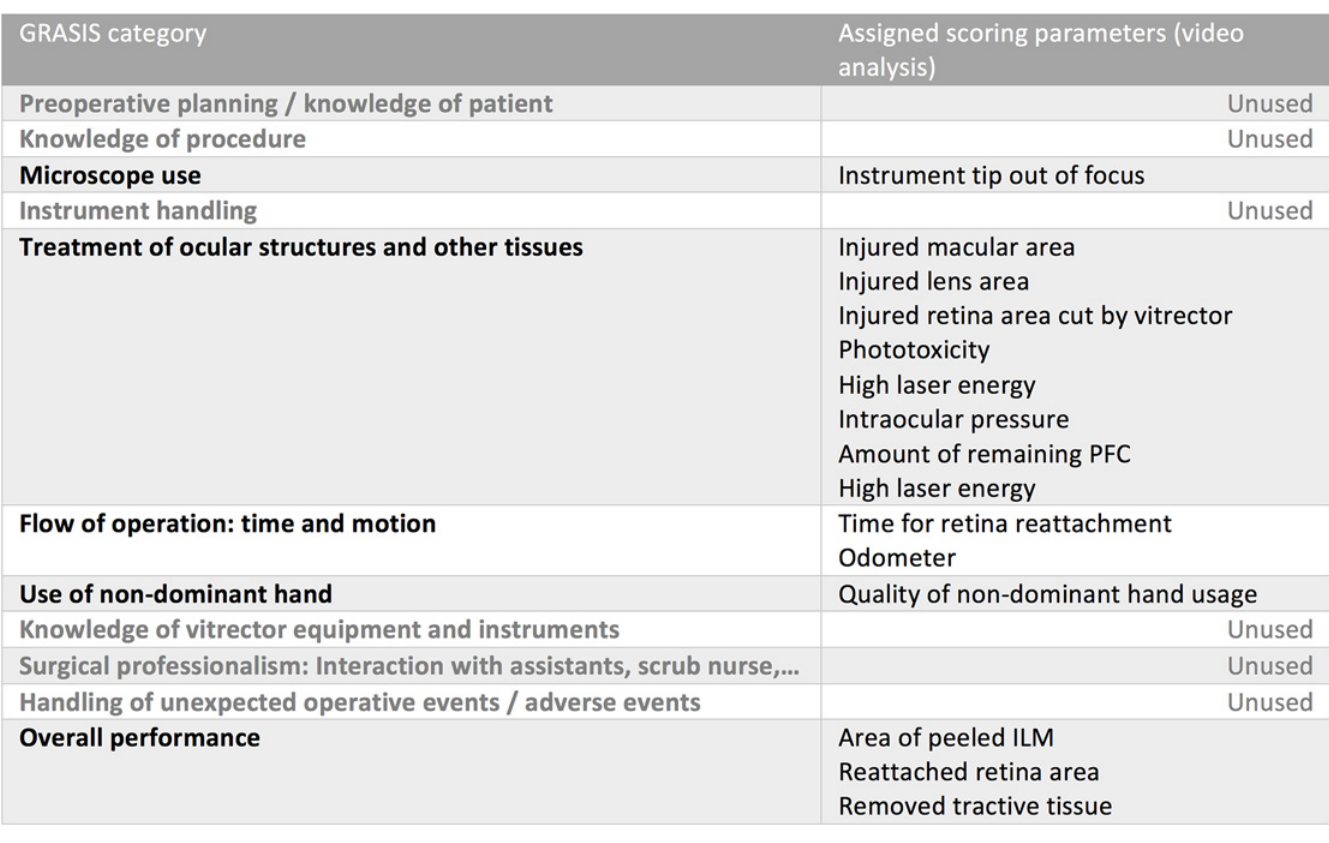
Fig 1. GRASIS categorization of the parameters as used by the video